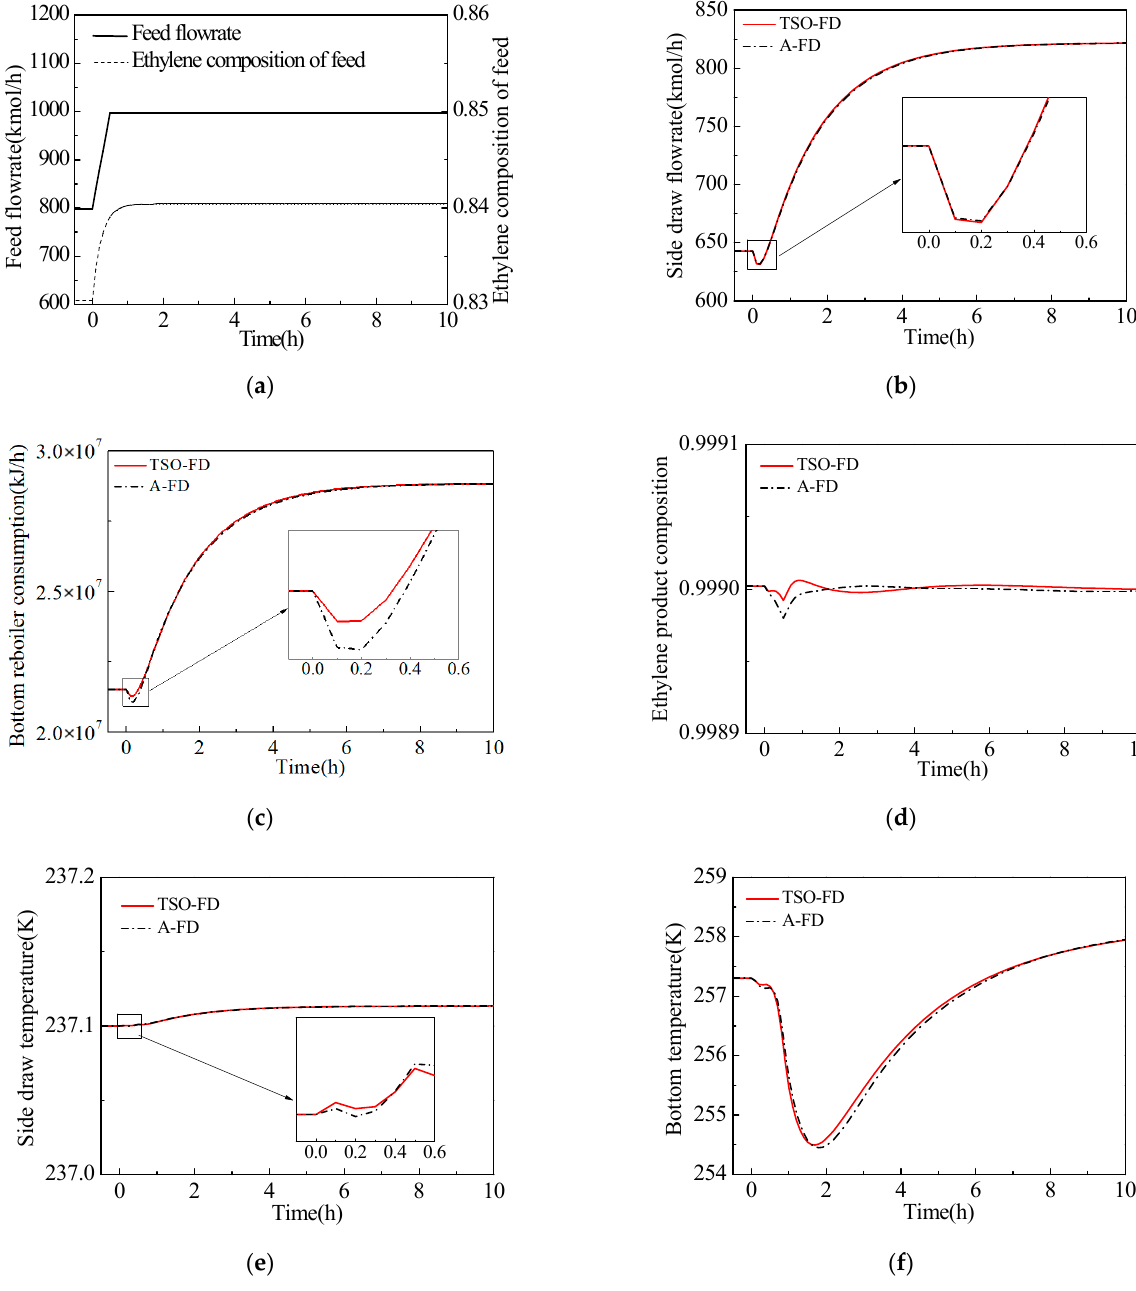
Figure 6. Transition results of the new process transition caused by the state changes of driving variables: ( a ) driving variable; ( b ) side draw flowrate; ( c ) bottom reboiler consumption; ( d ) ethylene product quality; ( e ) side draw temperature; ( f ) bottom